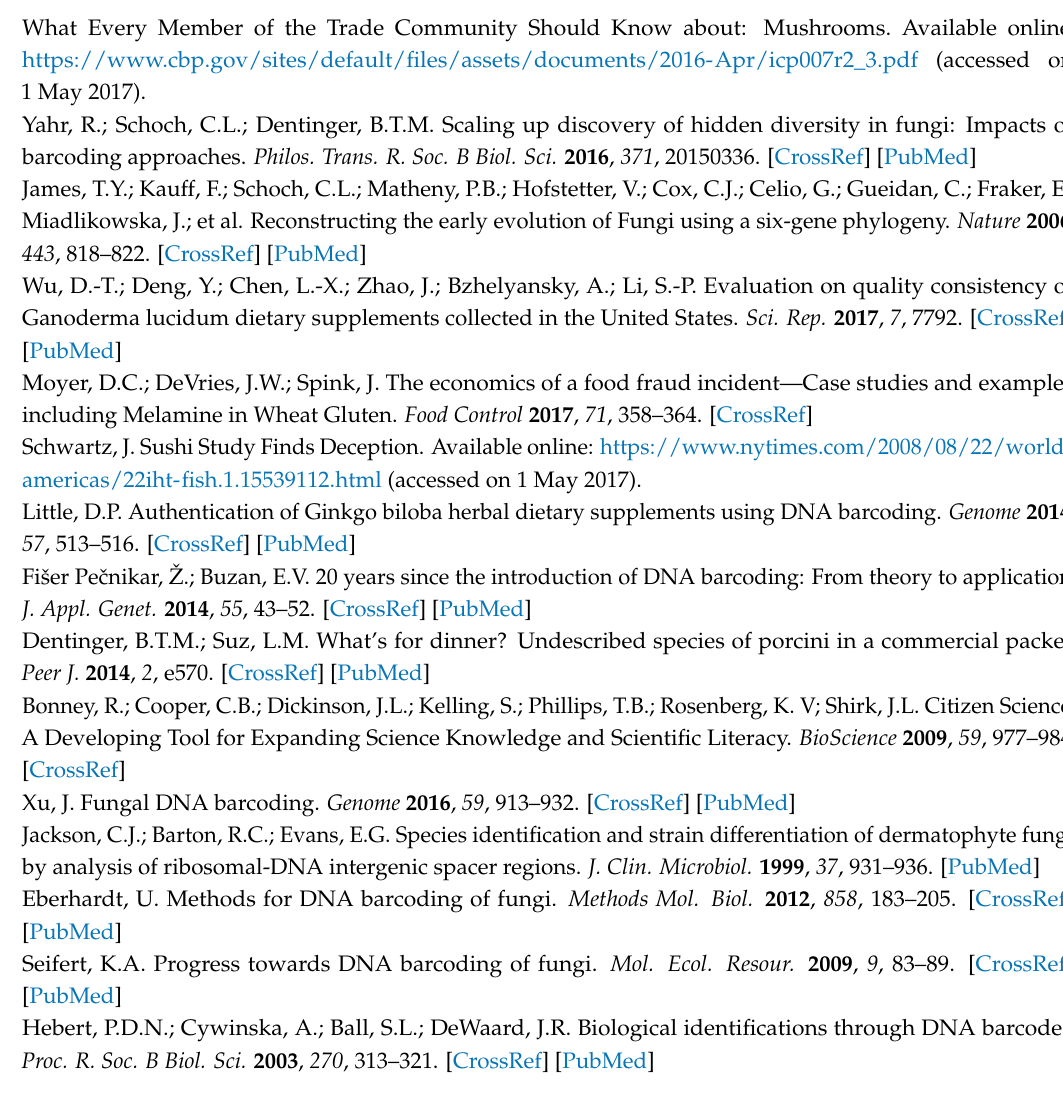
Table S1: Identification and consensus sequence information of all samples. Figure S1: A Clustal Omega alignment of samples S1 (Cloud Ear) and S8 (Korean Black), and two GenBank reference sequences (KM396796 ( Auricularia heimuer ) and KX621135 ( Auricularia auricula-judae